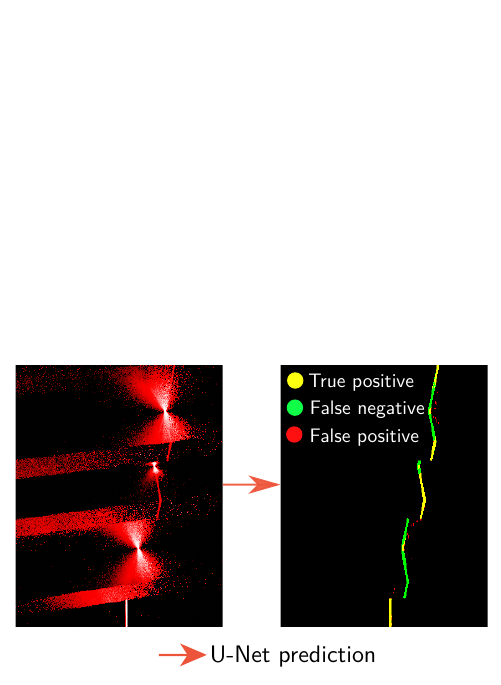
Figure 14: Strong blurry reflections may overlap the true scan line, such that it is not visible among the strong reflections.